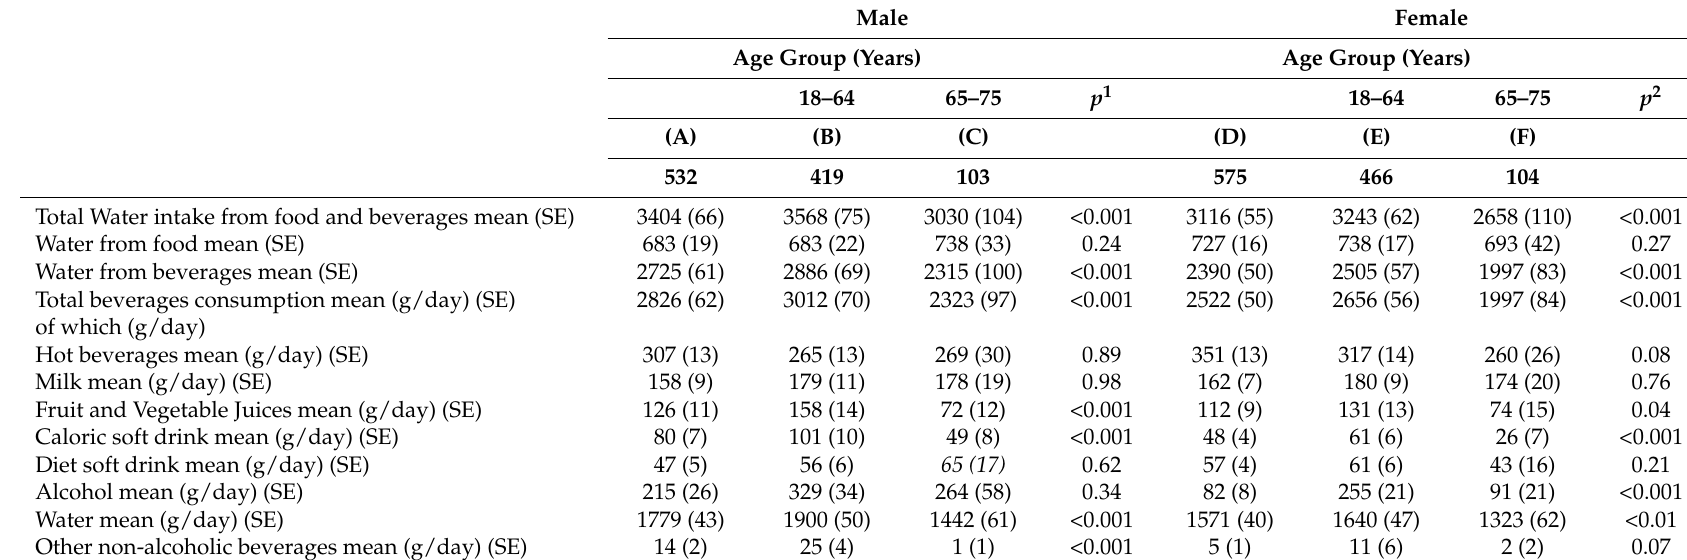
Table 3. Total water intake and beverage consumption (g/day) by age group of subjects using the WBQ ( n =